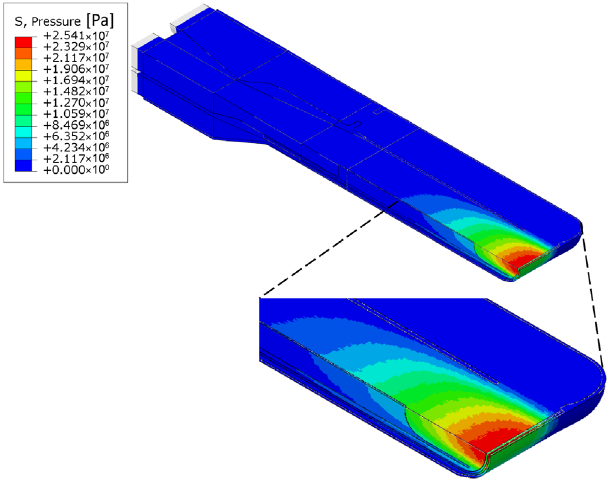
FIG. 5. Mid-vertical plane view of initial beam pulse pressure field in SNS